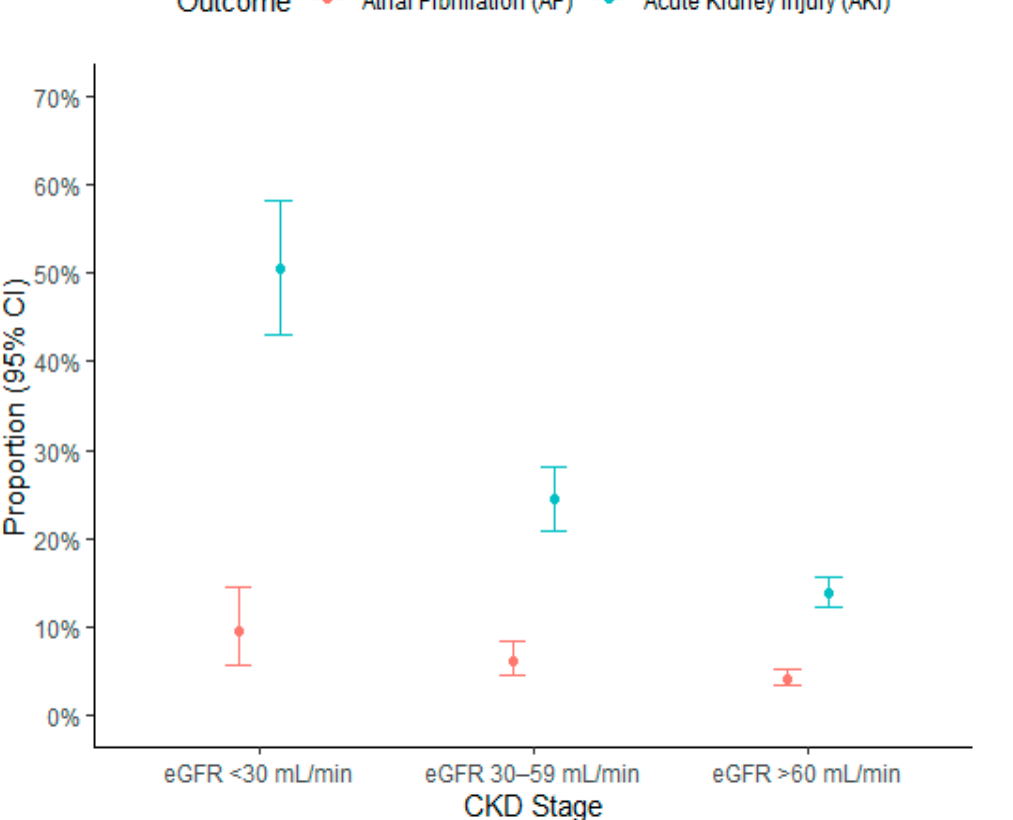
Figure 2. Proportion plot with 95% confidence interval for AF (in 2720 patients without permanent AF) and AKI (in 2550 patients with at least two creatinine measurements) according to chronic kidney disease. Abbreviations: AF, atrial fibrillation; AKI, acute kidney injury; CKD, chronic kidney disease; eGFR, estimated glomerular filtration rate.